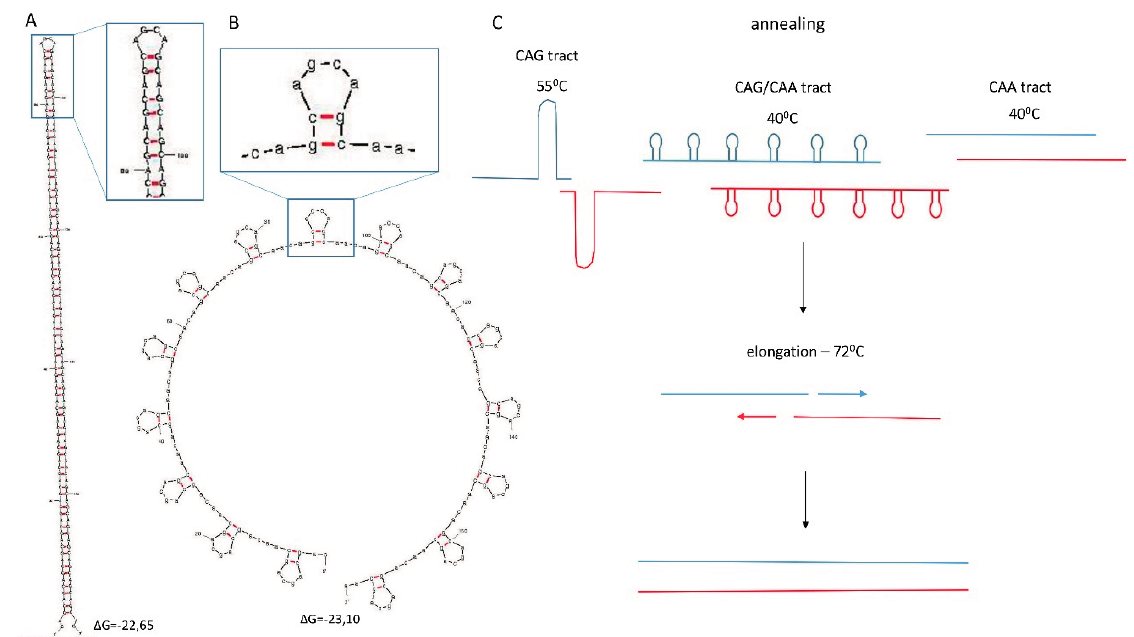
Figure 4. Structure of CAG and (CAG) 3 CAA repeat tracts predicted for 60 triplets using Mfold (DNA folding form), and hypothetical hairpin structure behavior during SLIP. Red and blue colors indicate products of Bsm BI and Eco 0109I restriction